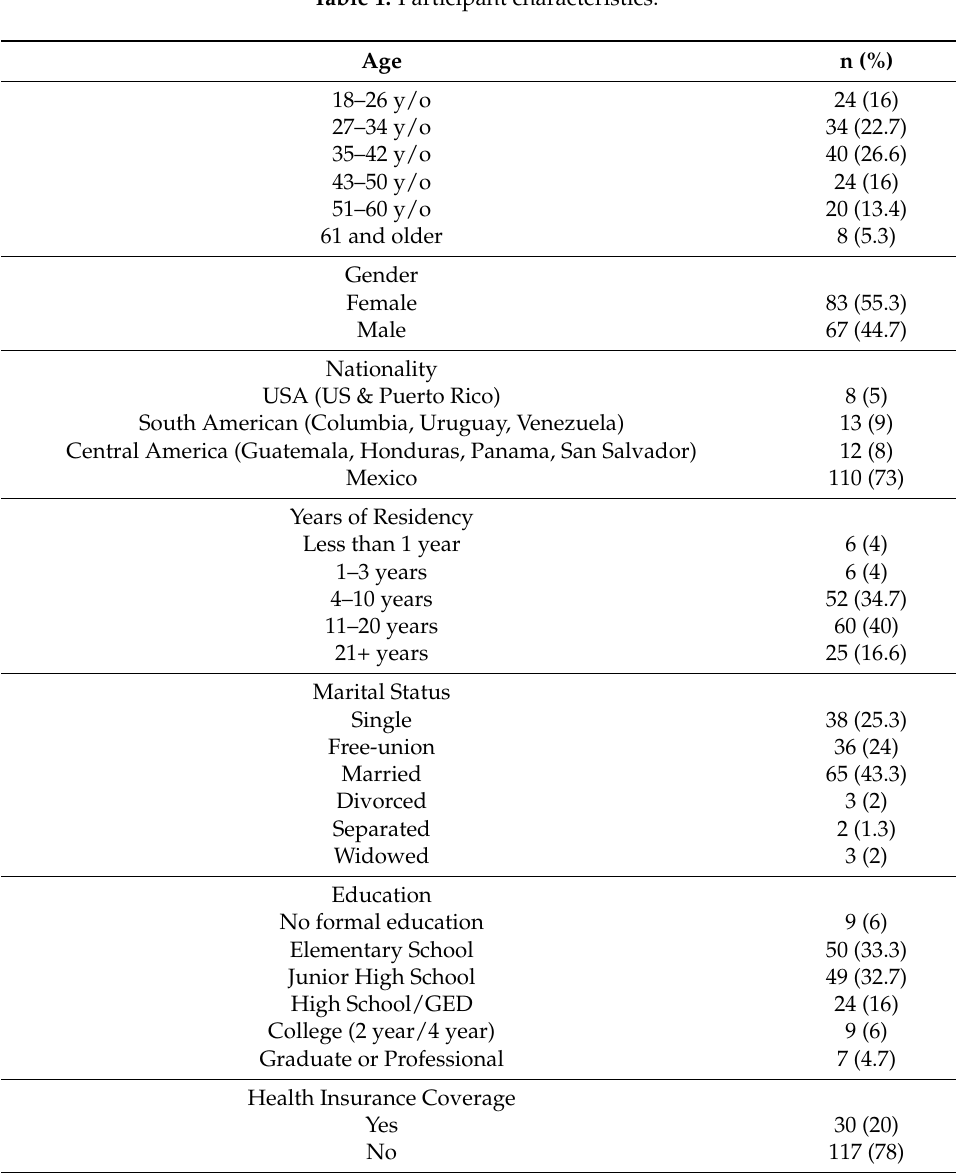
Table 1. Participant